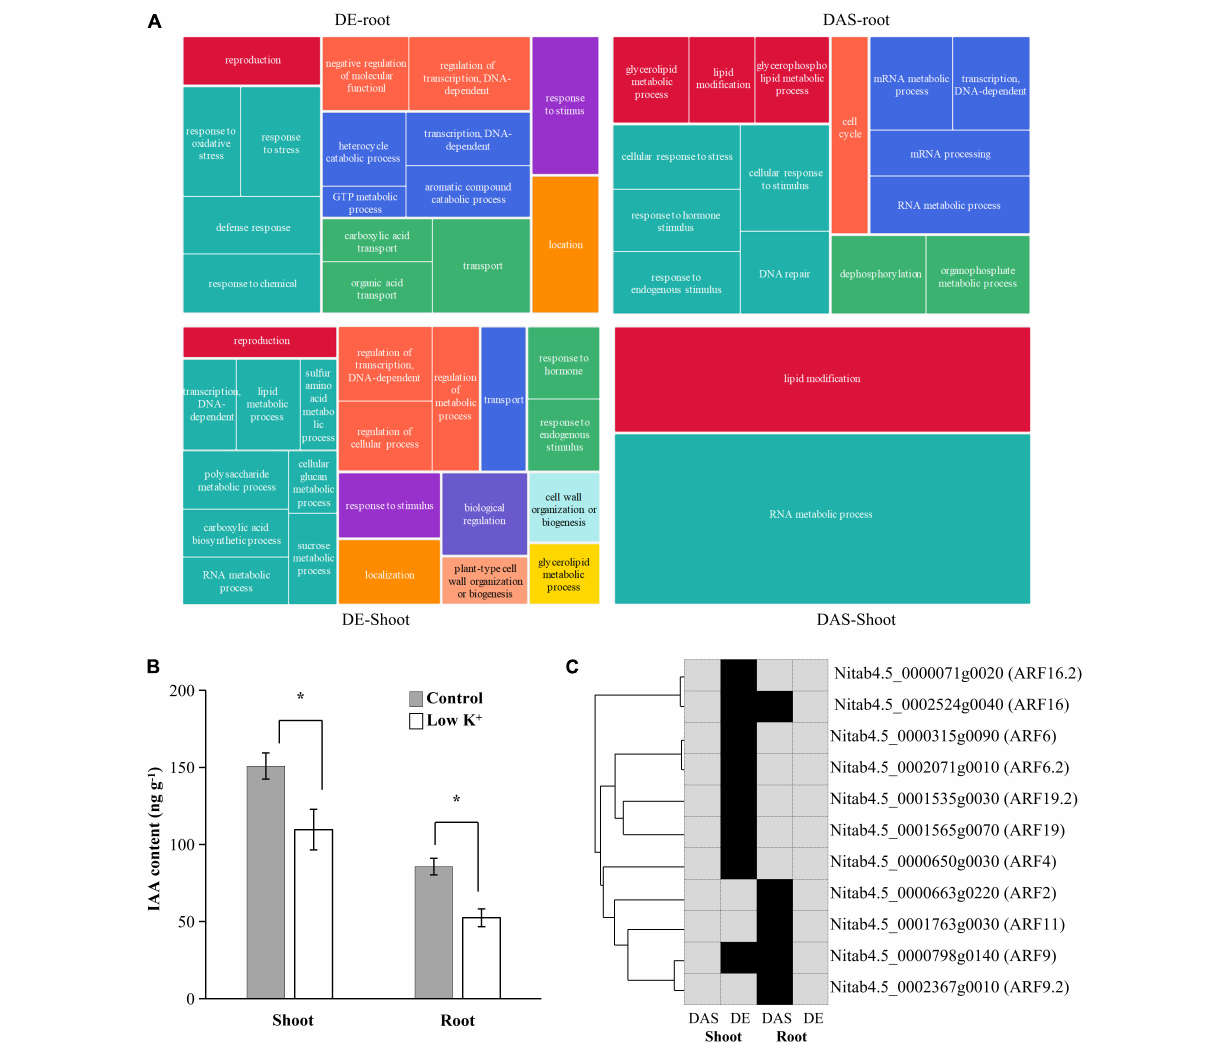
FIGURE 7 | Gene Ontology (GO) enrichment analysis of DAS and DE genes in shoots and roots. (A) Tree maps of representative GO terms in DAS and DE genes in shoots and roots. The drawings were plotted using REVIGO; (B) IAA content in leaves and roots of tobacco seedlings under control and low K + conditions. * p < 0.05 student’s t -test; (C) ARF transcription factors involved in GO term “Response to hormone.” The phylogenetic relationship of ARF transcription factors is shown on the left. Black, genes were differentially expressed (DE) or differentially alternatively spliced (DAS); Gray, genes were no significant